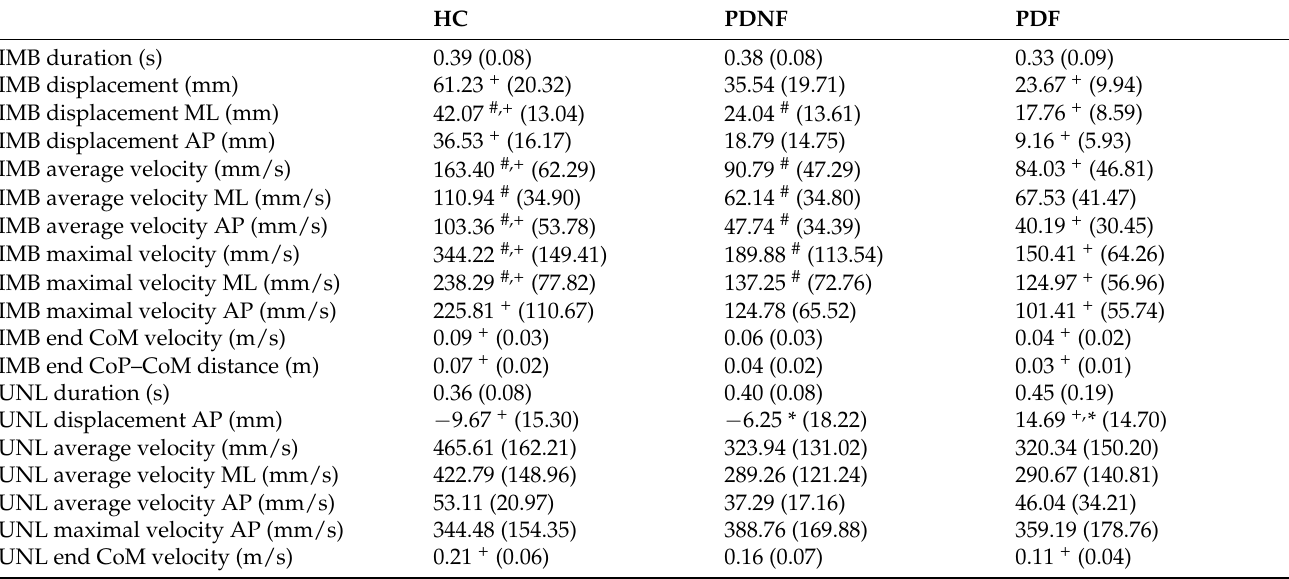
Table 3. Gait initiation measurements: comparison between groups. Only biomechanical variables not correlated with the base of support are listed. Data are shown as mean (standard deviation). The mediolateral CoP displacement during imbalance and unloading was considered positive when the shift in the CoP was towards the swing and the stance foot, respectively. The anteroposterior CoP displacement during imbalance and unloading phase were both defined as positive when the CoP movement was oriented backwards. Abbreviations: HC, healthy controls; PDF, Parkinson’s disease with freezing of gait; PDNF, Parkinson’s disease with no freezing of gait; refer to Table 1 for a list of other acronyms